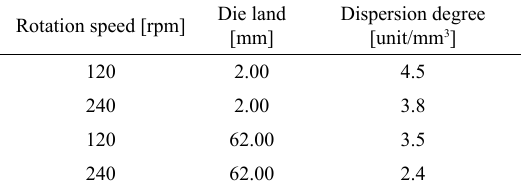
Table 2. Dispersion degree of the ABS particles in the PBT matrix as function of the rotation speed of the screws and extrusion die land, obtained with screw KB45/5/42 and feed rate of 7.0